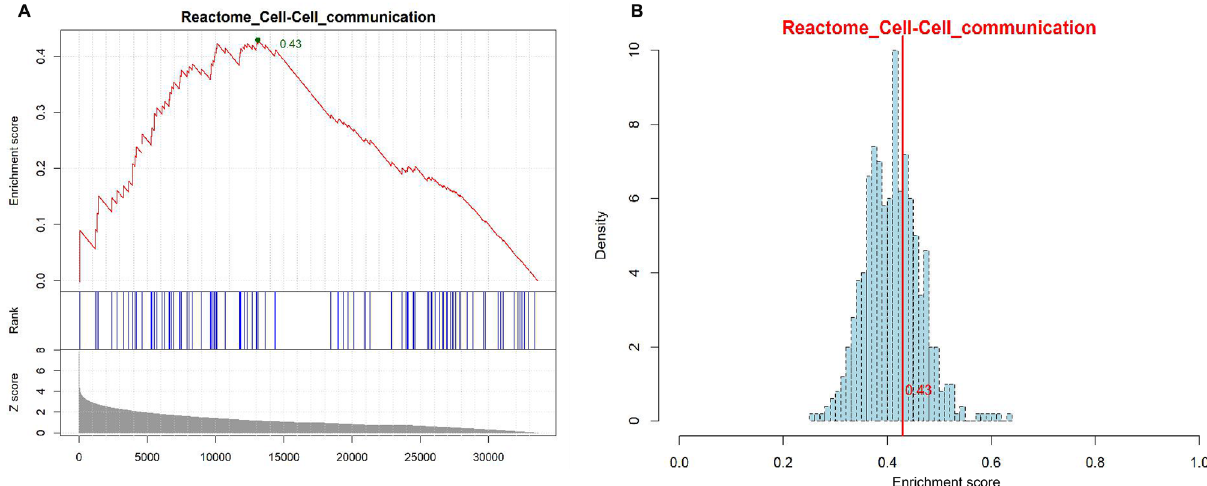
Figure 2. Illustration of the SPPA algorithm. A Shown is the estimation of the effect score (ES) of the “Cell–Cell communication” pathway. When all 112 genes are sorted according to the Z values of expression changes in the pathway, the highest enrichment score of the pathway based on running-sum statistic is calculated by finding the location of genes in the pathway. The score is 0.429, which is as effect score of smoke on this pathway. B Estimation of significance of effect score. 500 random simulations were performed to calculate whether the ES (0.429) of the example pathway reached a significant level. The estimation of P value is